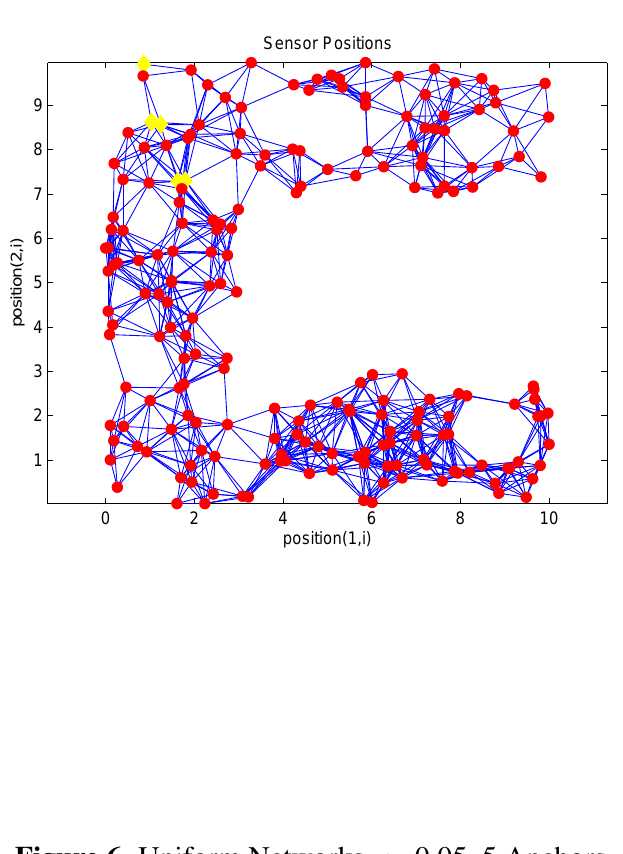
Figure 5 . C-shaped Network.